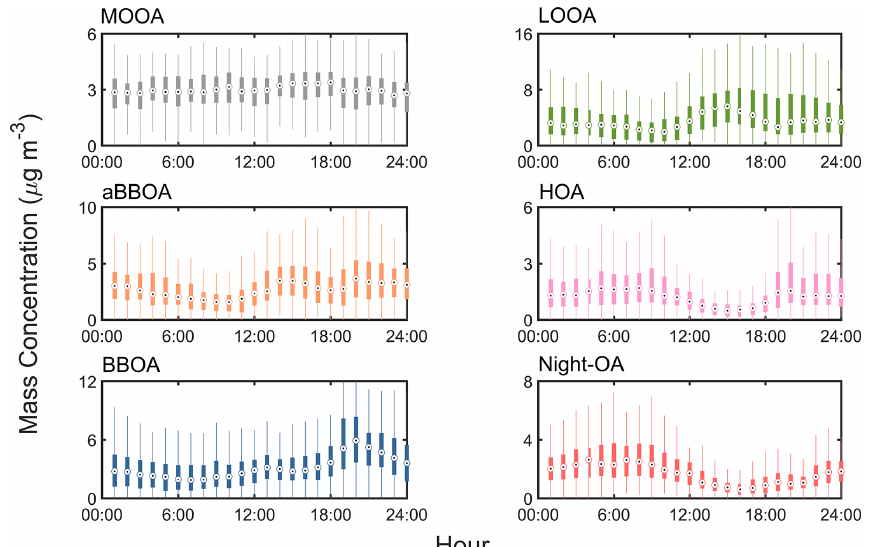
Figure 5. The diurnal variation (displayed in boxplot) mass concentration of the deconvolved OA factors from PMF analysis of AMS data, including more oxygenated OA (MOOA), less oxygenated OA (LOOA), aged biomass burning OA (aBBOA), hydrocarbon-like OA (HOA), biomass burning OA (BBOA), and nighttime OA